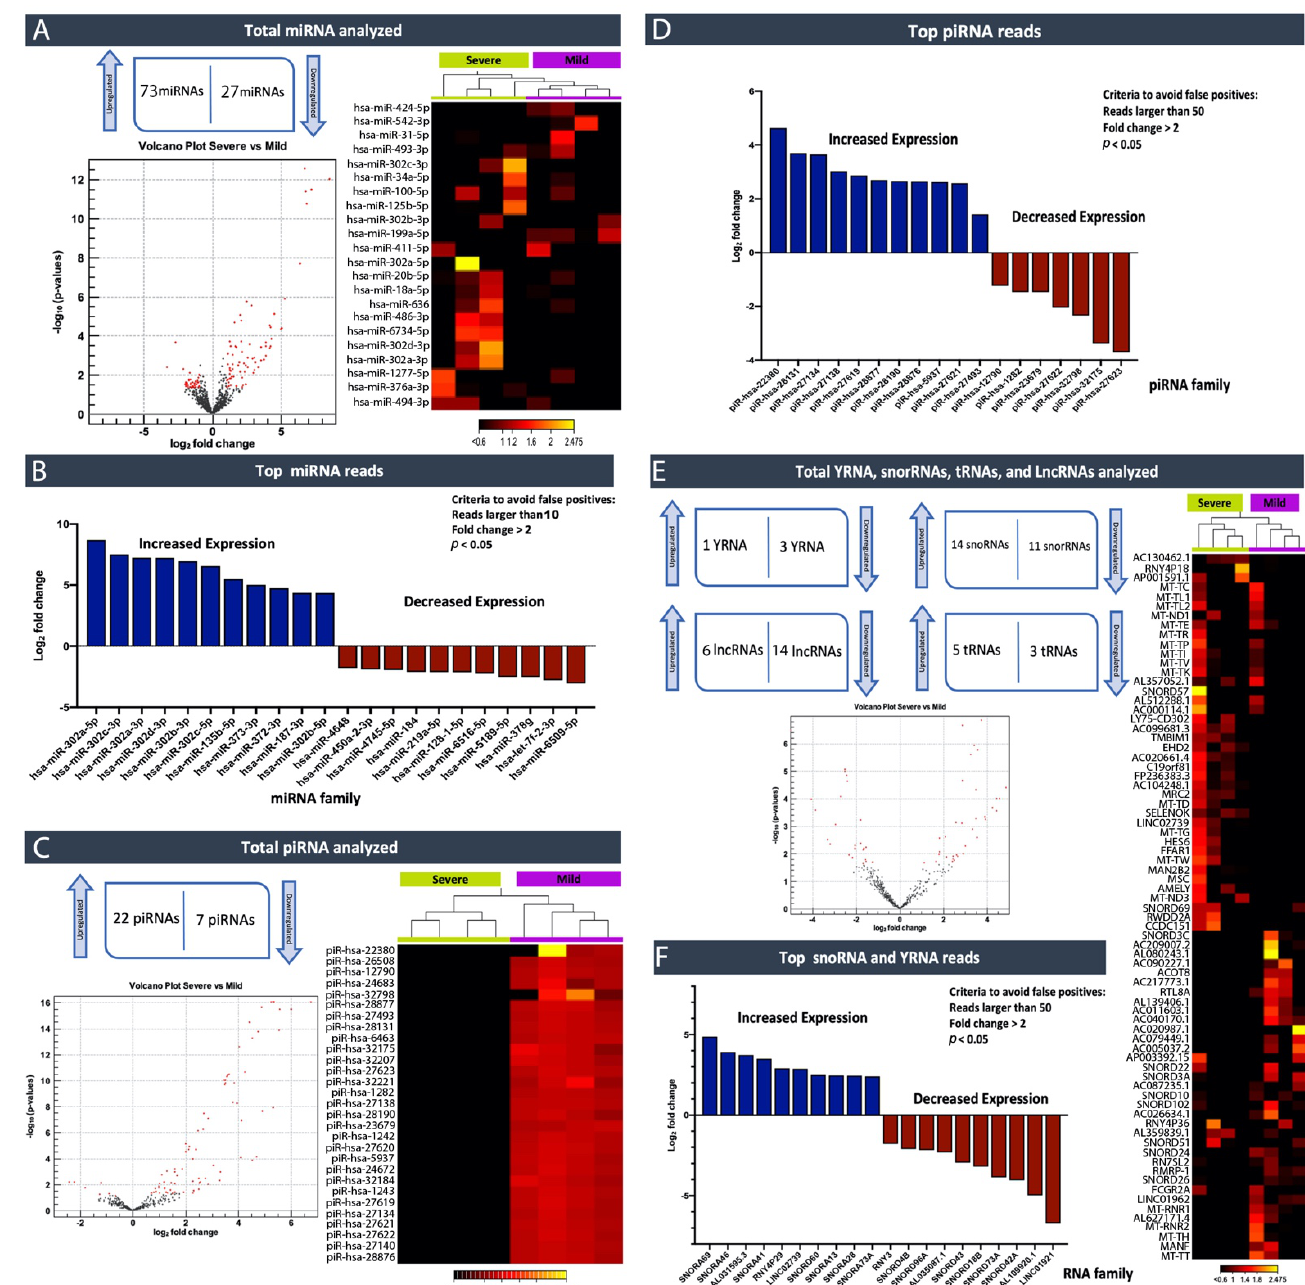
Figure 4. ncRNA expression analysis ASD individuals that manifest severe vs. mild symptoms using CLC Genomics Workbench v20.0.4 (Qiagen, Germany). ( A ) miRNA volcano plot (when using cutoff absolute fold change > 2, p -Value < 0.05, >10 reads per sample) and hierarchical clustering analysis of miRNA expression profile, a representative two-dimensional heatmap of expression values (4 Severe vs. 4 Mild). Each column corresponds to one sample, and each row corresponds to a miRNA. The samples and features are both hierarchically clustered. ( B ) Top 10 differentially expressed miRNAs in severe compared to mild (Log 2 fold change > 2; p < 0.05). ( C ) piRNA volcano plot (when using cutoff absolute fold change > 2, p -Value < 0.05, >50 reads per sample) and two-dimensional heat map of expression values. Each column corresponds to one sample, and each row corresponds to a piRNA. The samples and features are both hierarchically clustered. ( D ) Top 10 differentially expressed piRNAs in in severe compared to mild (Log 2 fold change > 2; p < 0.05). ( E ) Other ncRNA volcano plot (when using cutoff absolute fold change > 2, p -Value < 0.05, >50 reads per sample) and two-dimensional heat map of expression values. Each column corresponds to one sample, and each row corresponds to a ncRNAs. ( F ) Top 10 differentially expressed other ncRNAs in severe compared to mild.